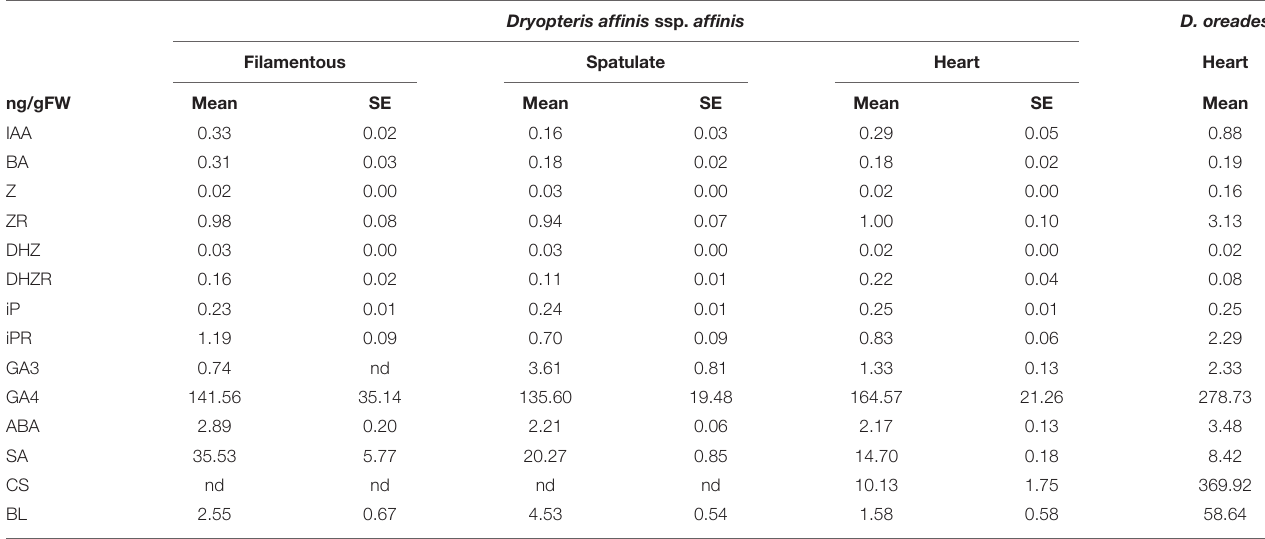
TABLE 3 | Endogenous content of phytohormones in three growth stages of apogamous fern Dryopteris affinis and one stage of its relative D. oreades